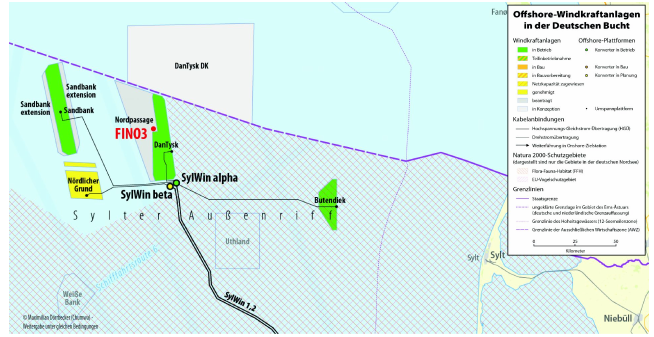
Figure 9. Location of FiNO 3 . Data source: